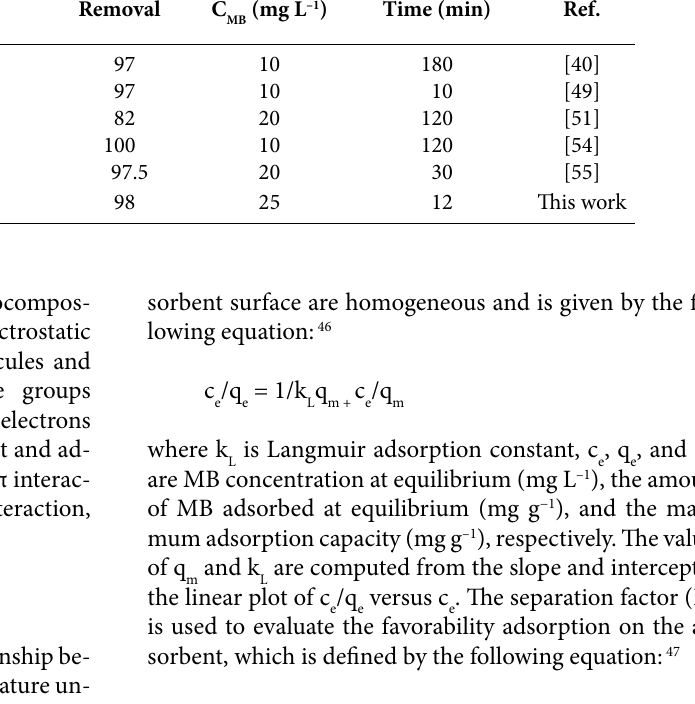
O nanocomposite: (a) Langmuir isotherm, (b) Freundlich isotherm. 3 4